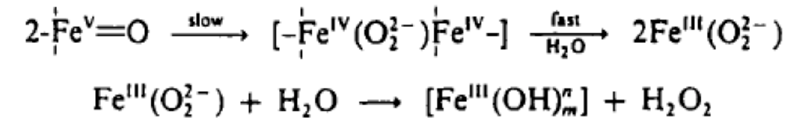
Figure 12. A diferrate(IV) intermediate acting as the O 2 releasing agent [130].